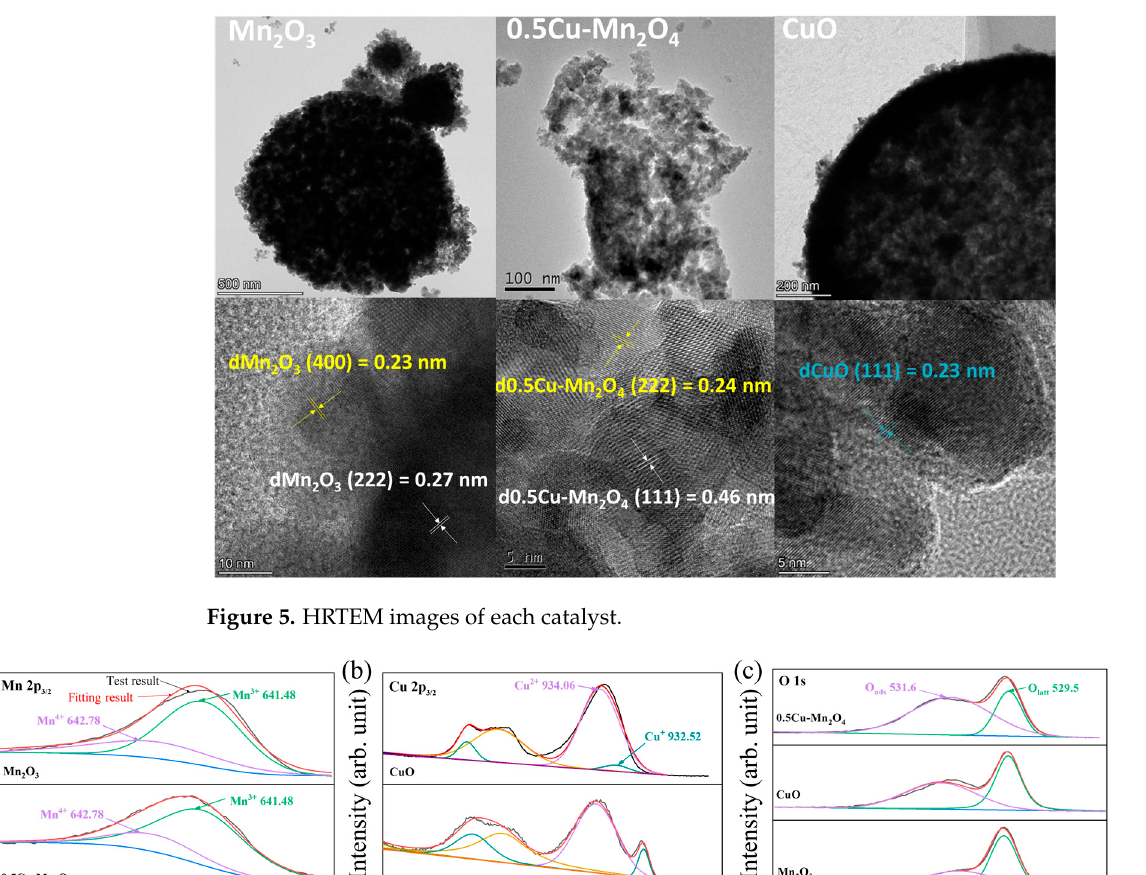
Figure 5. HRTEM images of each catalyst.